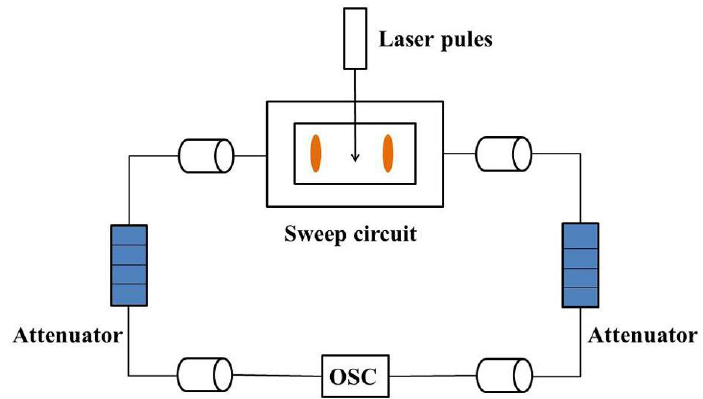
Figure 3. Schematic diagram of the testing circuit.